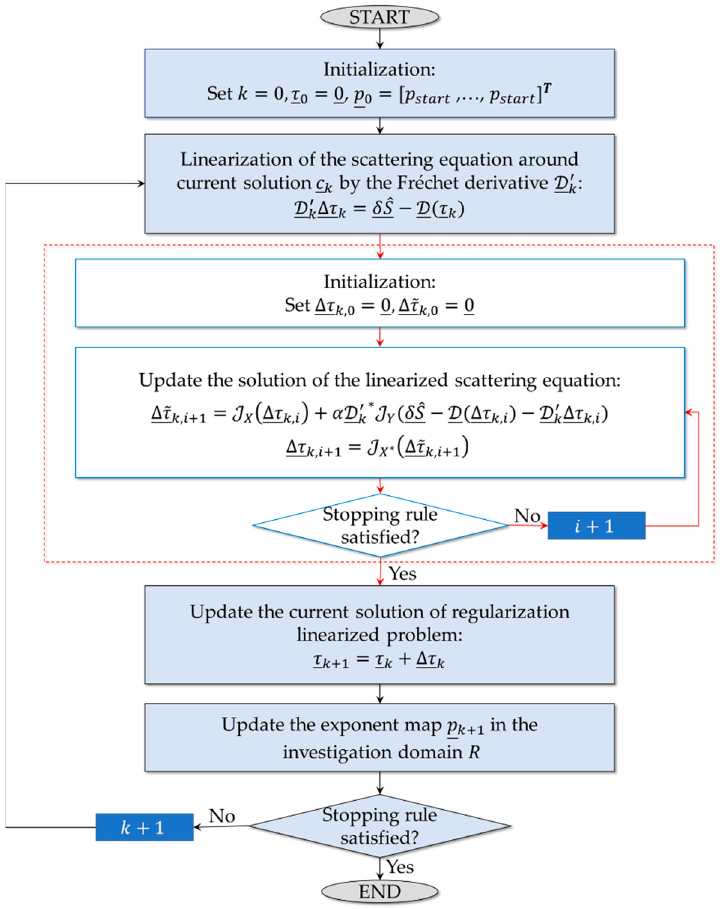
Figure 4. Flowchart of the inversion procedure.